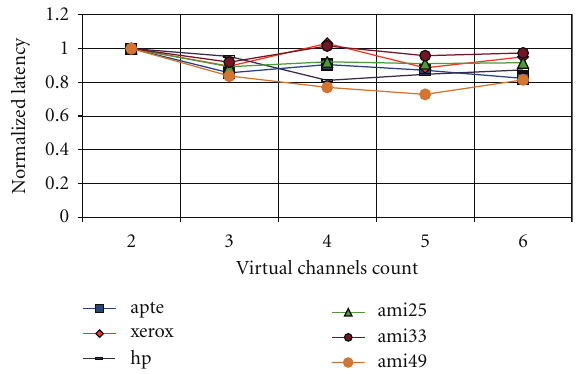
Figure 14: Normalized latency with variation of the number of virtual channels for the packet injection rate when the network saturation occurs.